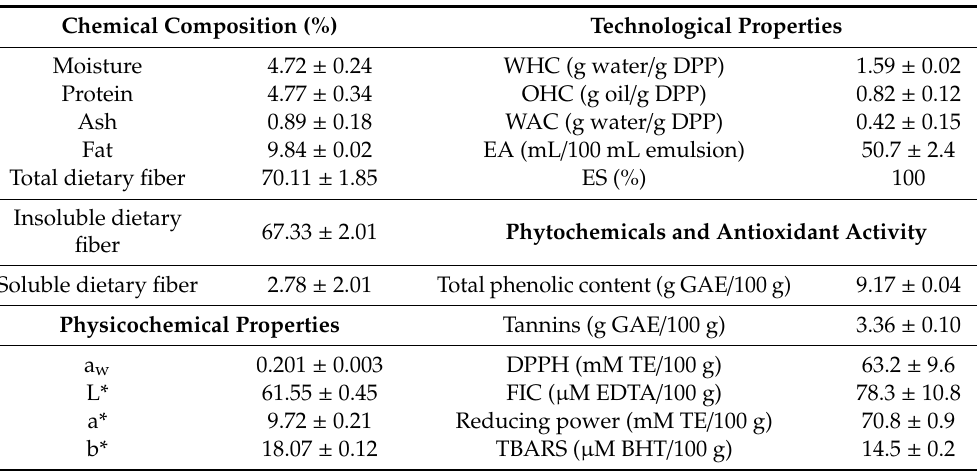
Table 1. Characterization of date pit coproduct.